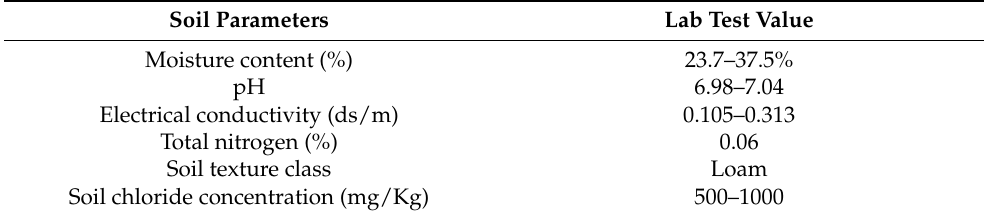
Table 3. Soil physicochemical